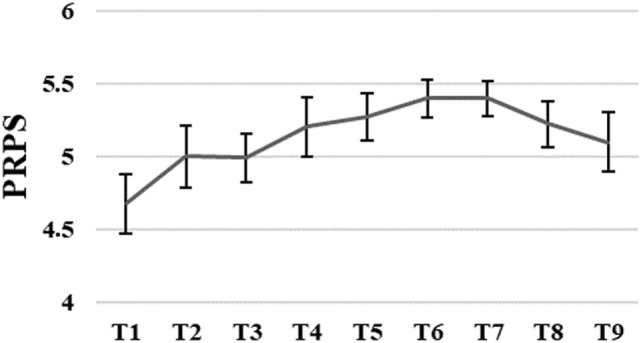
Group means with SEM for the results of the Pittsburgh Rehabilitation Participation Scale (PRPS) scores measured at different time points.